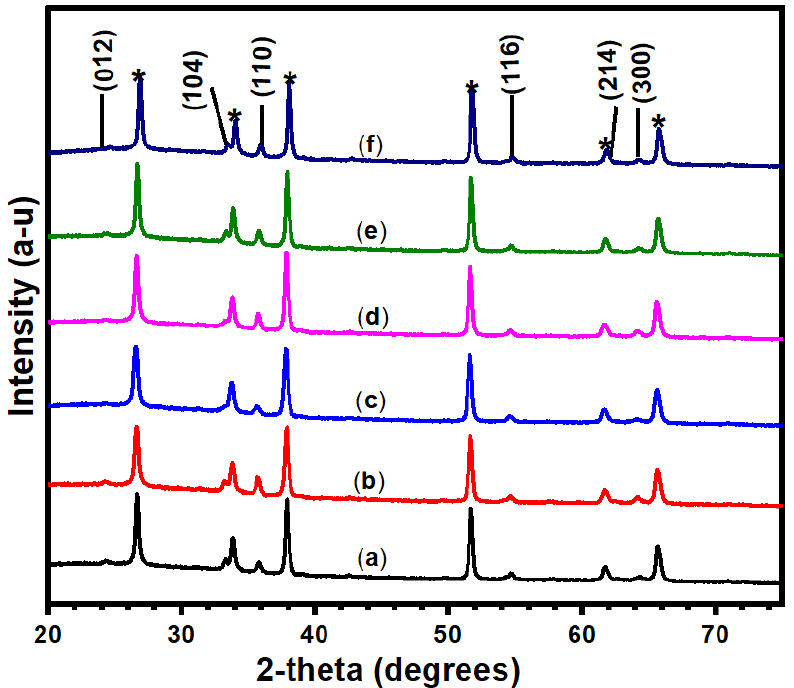
Figure 4. X-ray diffraction patterns of (a) pristine hematite NRs, (b) 3 mM Zn/3 mM Ni, (c) 3 mM Zn/5 mM Ni, (d) 3 mM Zn/7 mM Ni, (e) 3 mM Zn/9 mM Ni, and (f) 3 mM Zn-doped NRs.